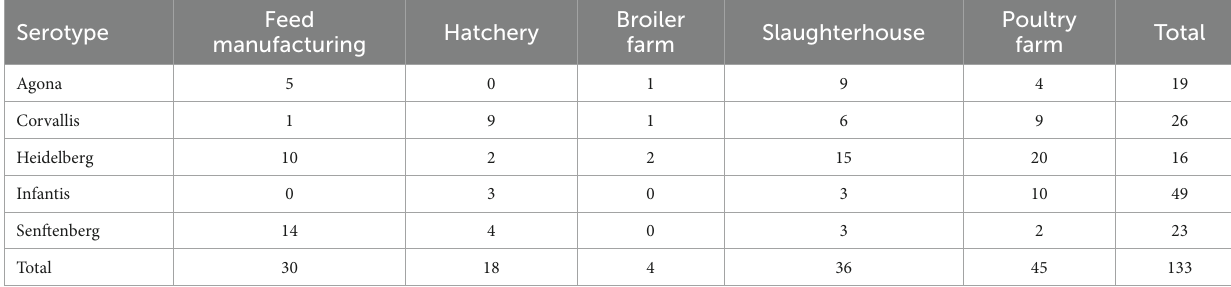
TABLE 1 Distribution of the isolated serotypes in the production